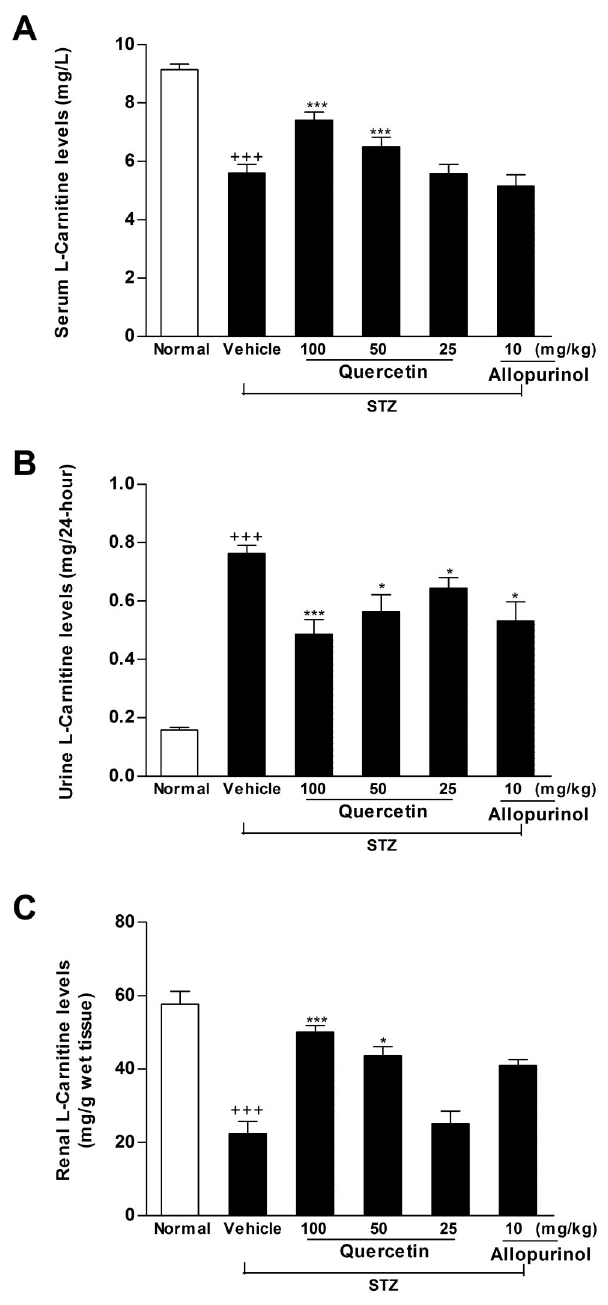
Figure 8. Quercetin and allopurinol regulate renal L-carnitine levels in streptozotocin (STZ)-treated rats. Biochemical analyses showed L-carnitine levels in serum (A) and urine (B) and kidney (C) at 7 weeks after STZ injection in different groups of rats as indicated. The data are expressed as the means 6 SEM (n=8). +++ P , 0.001 versus normal control; * P , 0.05, ** P , 0.01, *** P , 0.001 versus STZ